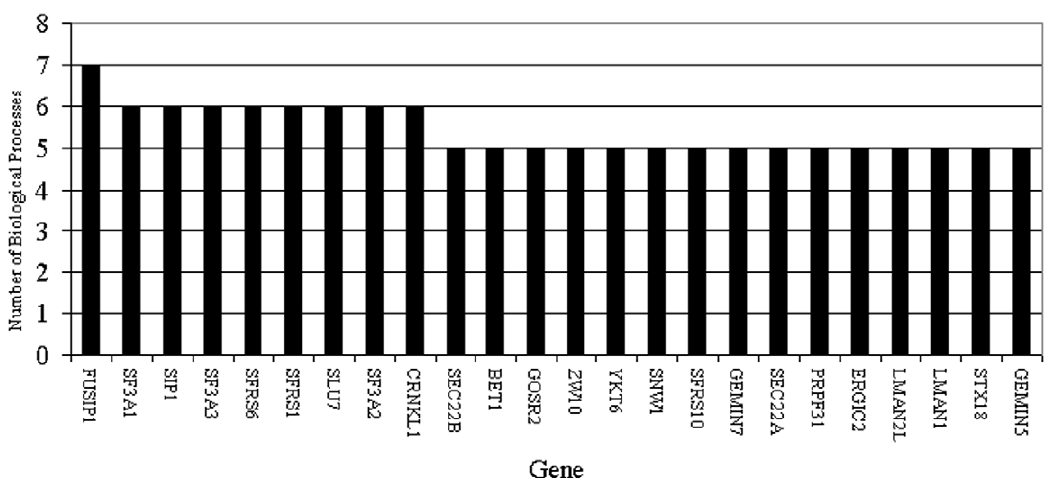
Figure 2. Leading edge analysis of genes downregulated by IFN- b + APAP treatment relative to IFN- b treatment at 4 h. A total of 178 genes contribute to the enrichment of 14 biological pathways down-regulated in the IFN- b + APAP treatment group relative to IFN- b alone. The 24 genes that participate in 5 or more of these pathways are shown.